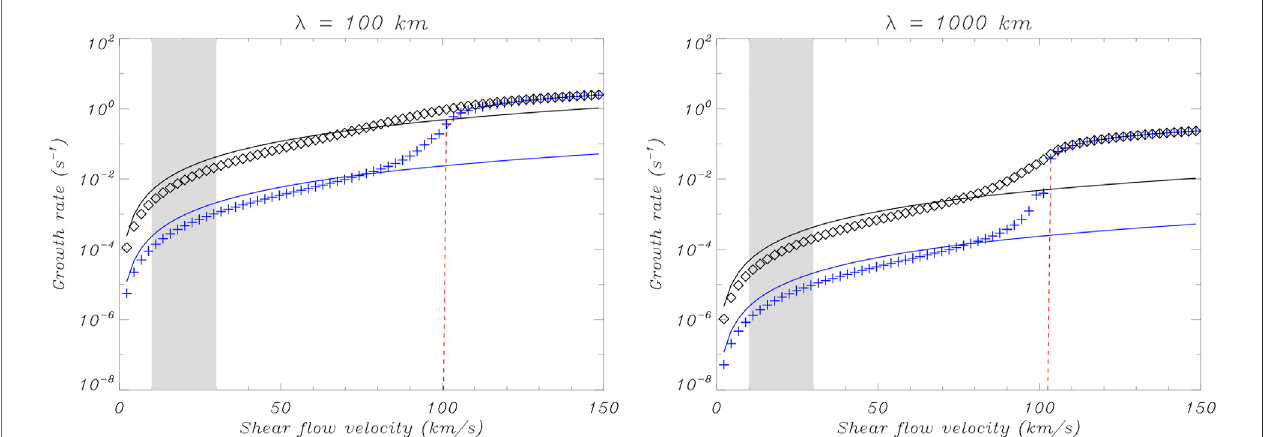
FIGURE 2 | KHi growth rate in a solar prominence thread asa function ofthe shear fl owvelocity at the thread boundary for two values ofthe longitudinal wavelength: 100 km (left panel) and 1,000 km (rightpanel) .Inboth panels,thered dashedlinescorrespondtothe caseofafully ionized plasma, thebluecrosses toa partiallyionized case,andtheblackdiamondstoaweaklyionizedcase.Thesolidlinesaretheanalyticalapproximationof Eq.34 .Theshadedzonedenotestheregionof fl owvelocityvalues that have been frequently measured in solar prominences. Credit: Martínez-Gómez et al. (2015), A&A 578, A104, reproduced with permission © ESO.